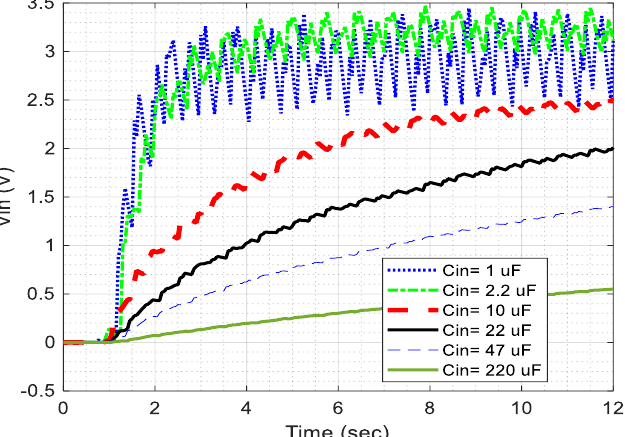
Figure 6. Storage voltage ( V in ) vs. time for various storage capacitors ( C in ); f = 3.3 Hz .